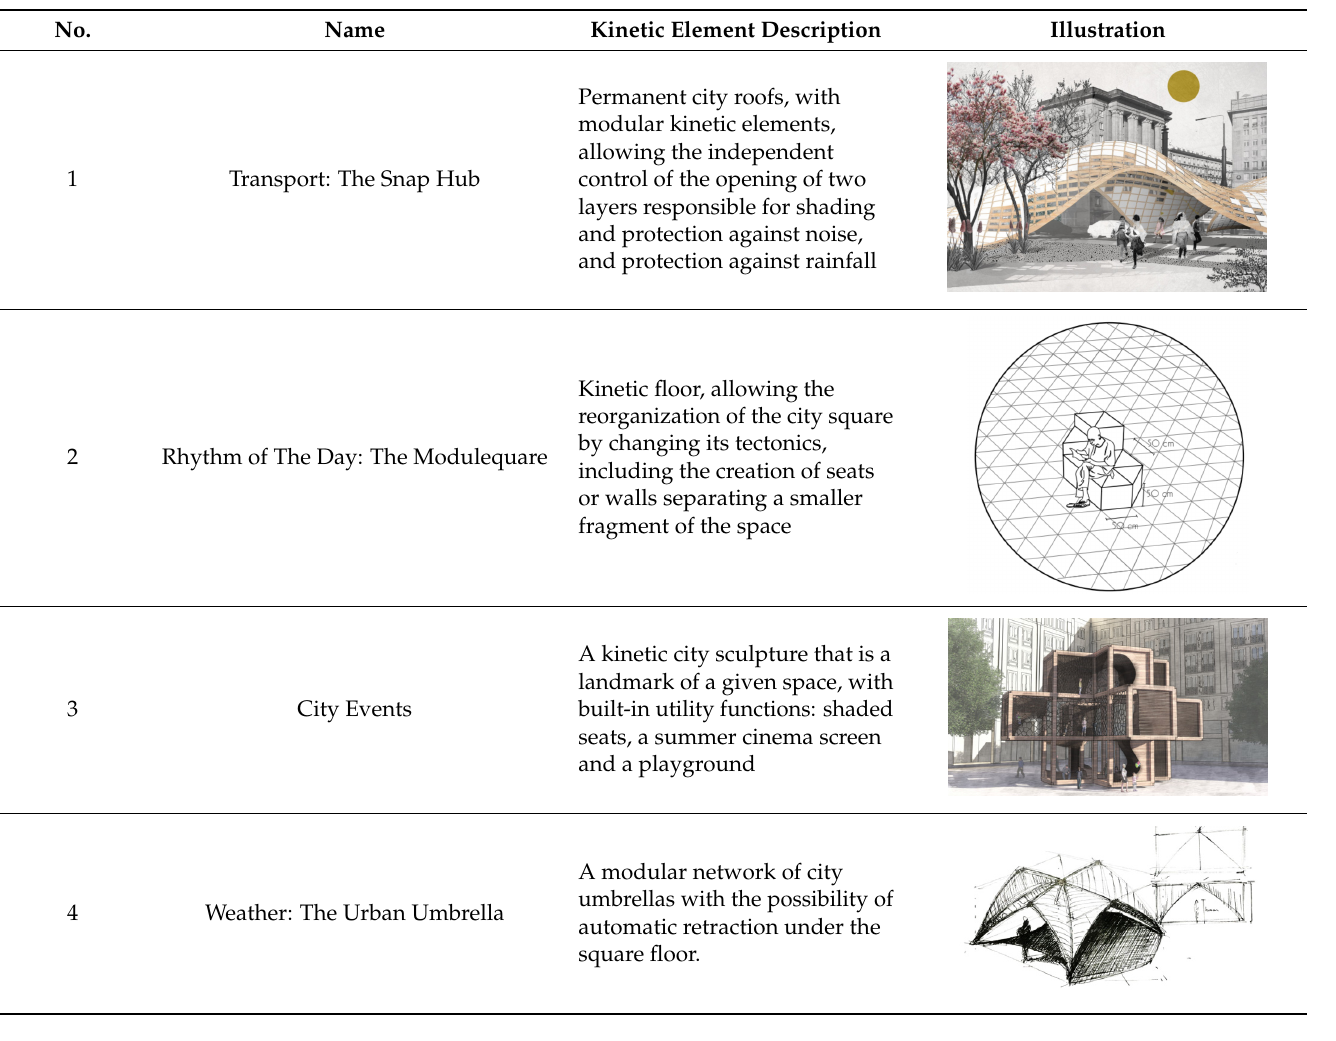
Table 1. A list of the analyzed student projects, presenting the kinetic design proposals of individual teams.